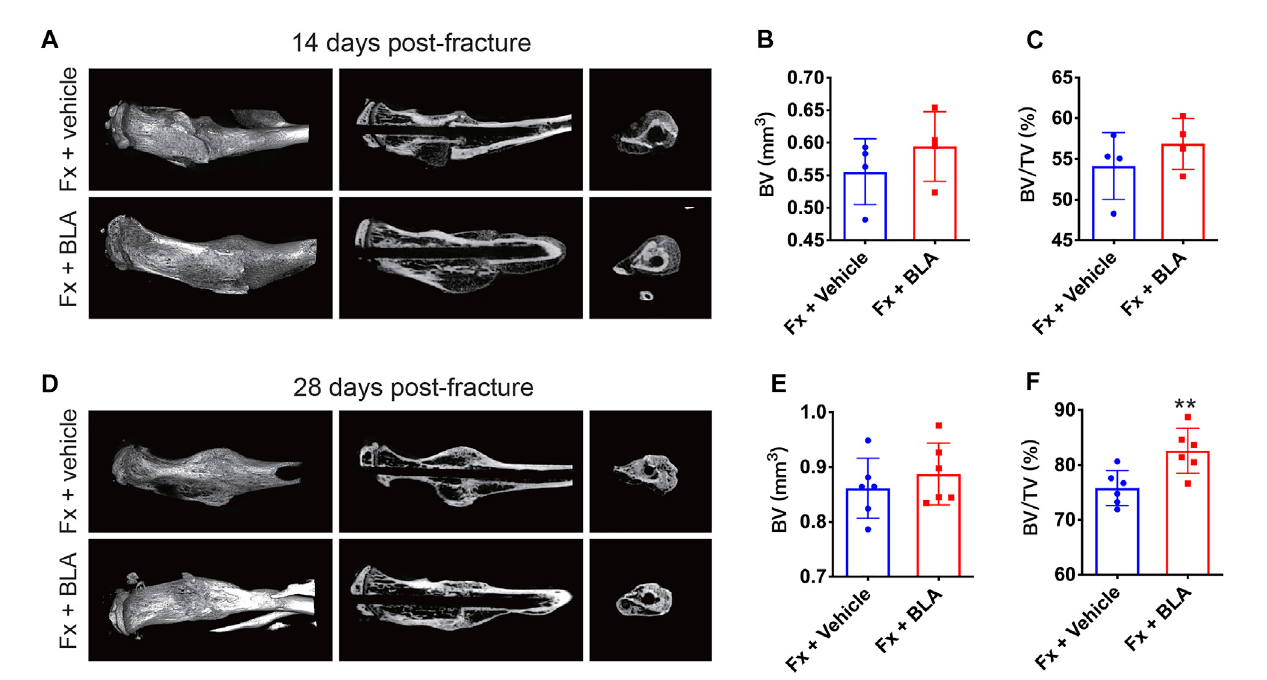
FIGURE 4 μ CT analysis of callus formation (A) Representative μ CT 3D reconstructions, coronal cross-sectional images, and axial cross-sectional images of fractured tibias fromvehicleandBLAgroupson day14 afterfracture. (B,C) Quantitativeanalysis of (B) thebonevolume(BV)and (C) thebonevolume fraction (BV/TV) of callus on day 14 after fracture. N = 4 per group. (D) Representative μ CT 3D reconstructions, coronal cross-sectional images, and axial cross- sectional images of fractured tibias from vehicle and BLA groups on day 28 after fracture. (E, F) Quantitative analysis of (E) BV and (F) BV/TV of callus on day 28 after fracture. N = 6 per group. Values are expressed as mean ± SD. Independent-sample t -test: * p < 0.05, ** p < 0.01 when compared with vehicle